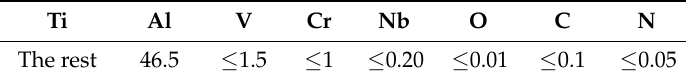
Table 1. Chemical composition of γ -TiAl (wt %).